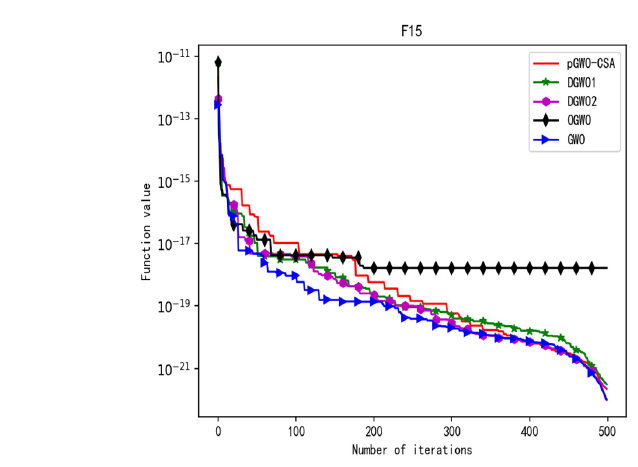
Figure 33. Convergence curve of test function F14.